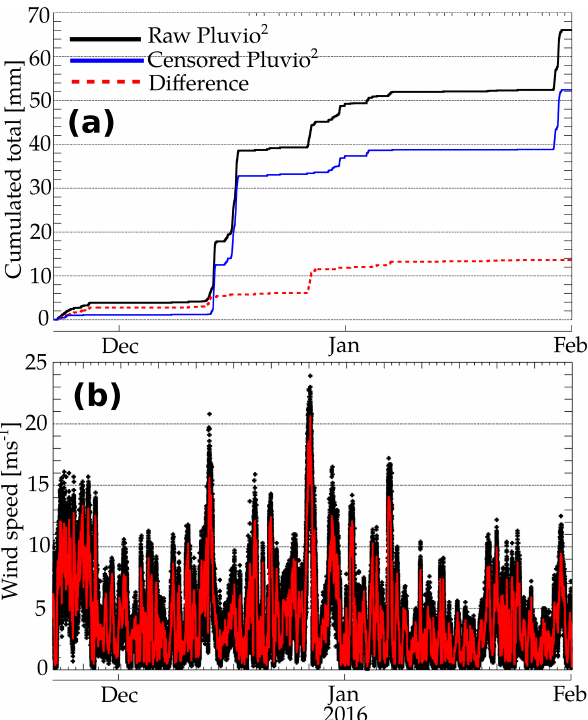
Figure 5. (a) Time series of Pluvio 2 untreated data, censored data (taking the MRR measurements as occurrence indicators), and their difference. (b) Wind speed measured in the near proximity ( ≤ 2m) of the Pluvio 2 inlet, at the temporal resolution of